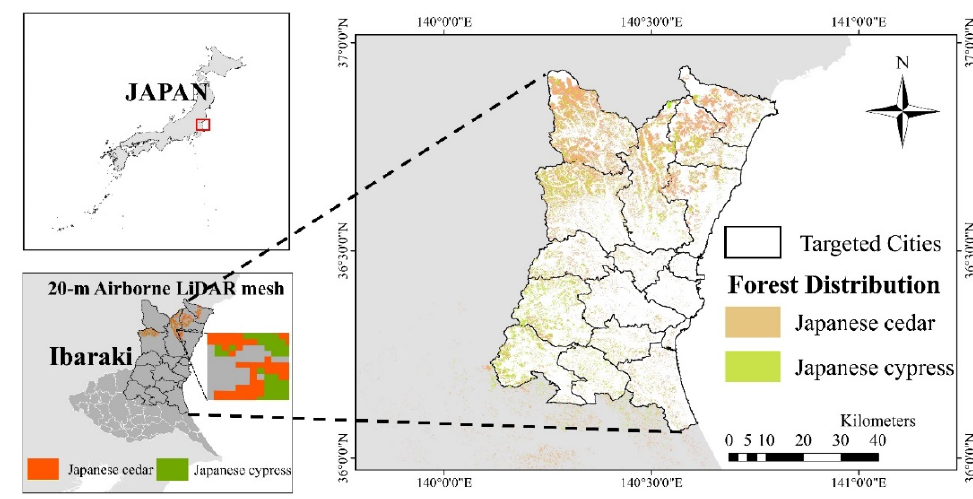
Figure 1. Location of the study area in Japan’s Ibaraki prefecture.